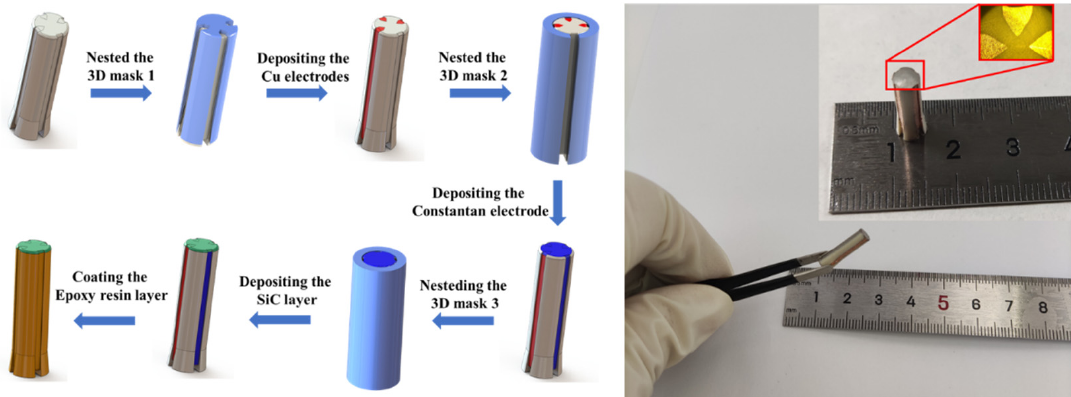
Table 2. The sputtering parameters of three-dimensional probe array temperature sensor. Sputtering Parameters